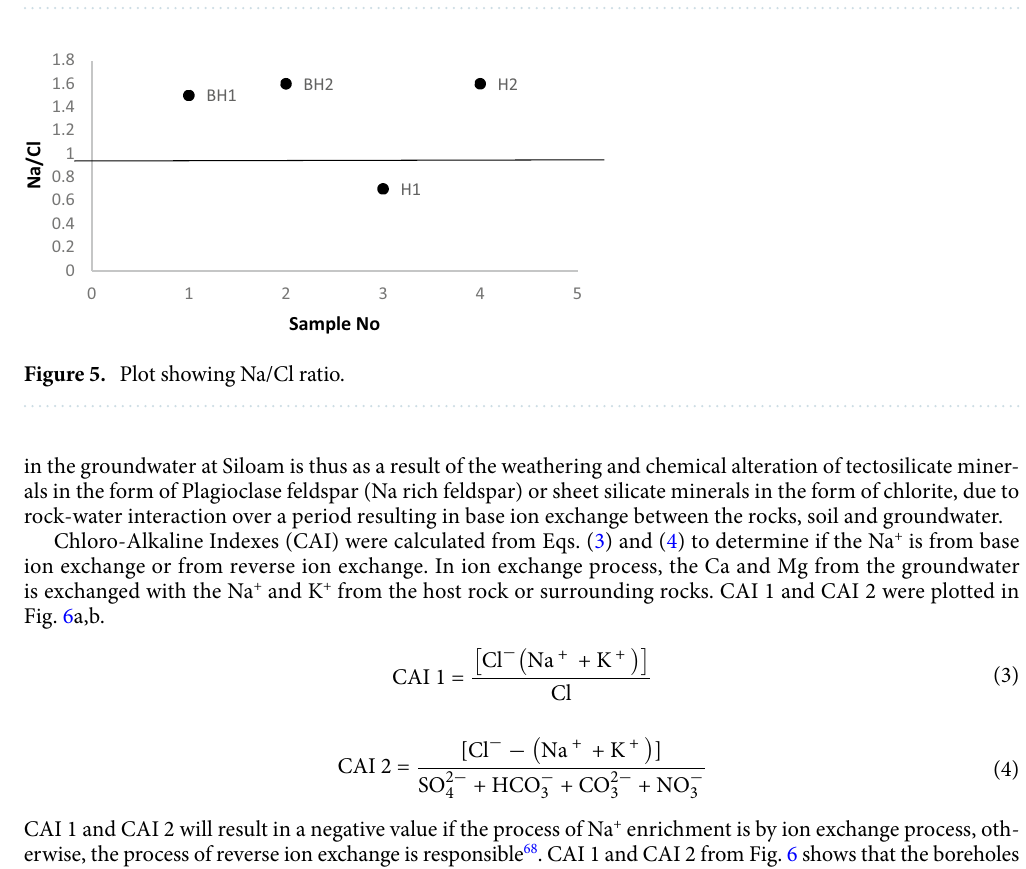
Figure 4. Gibbs plot showing dominant anion ( A ) and cation ( B ) mineralisation process of groundwater in Siloam.